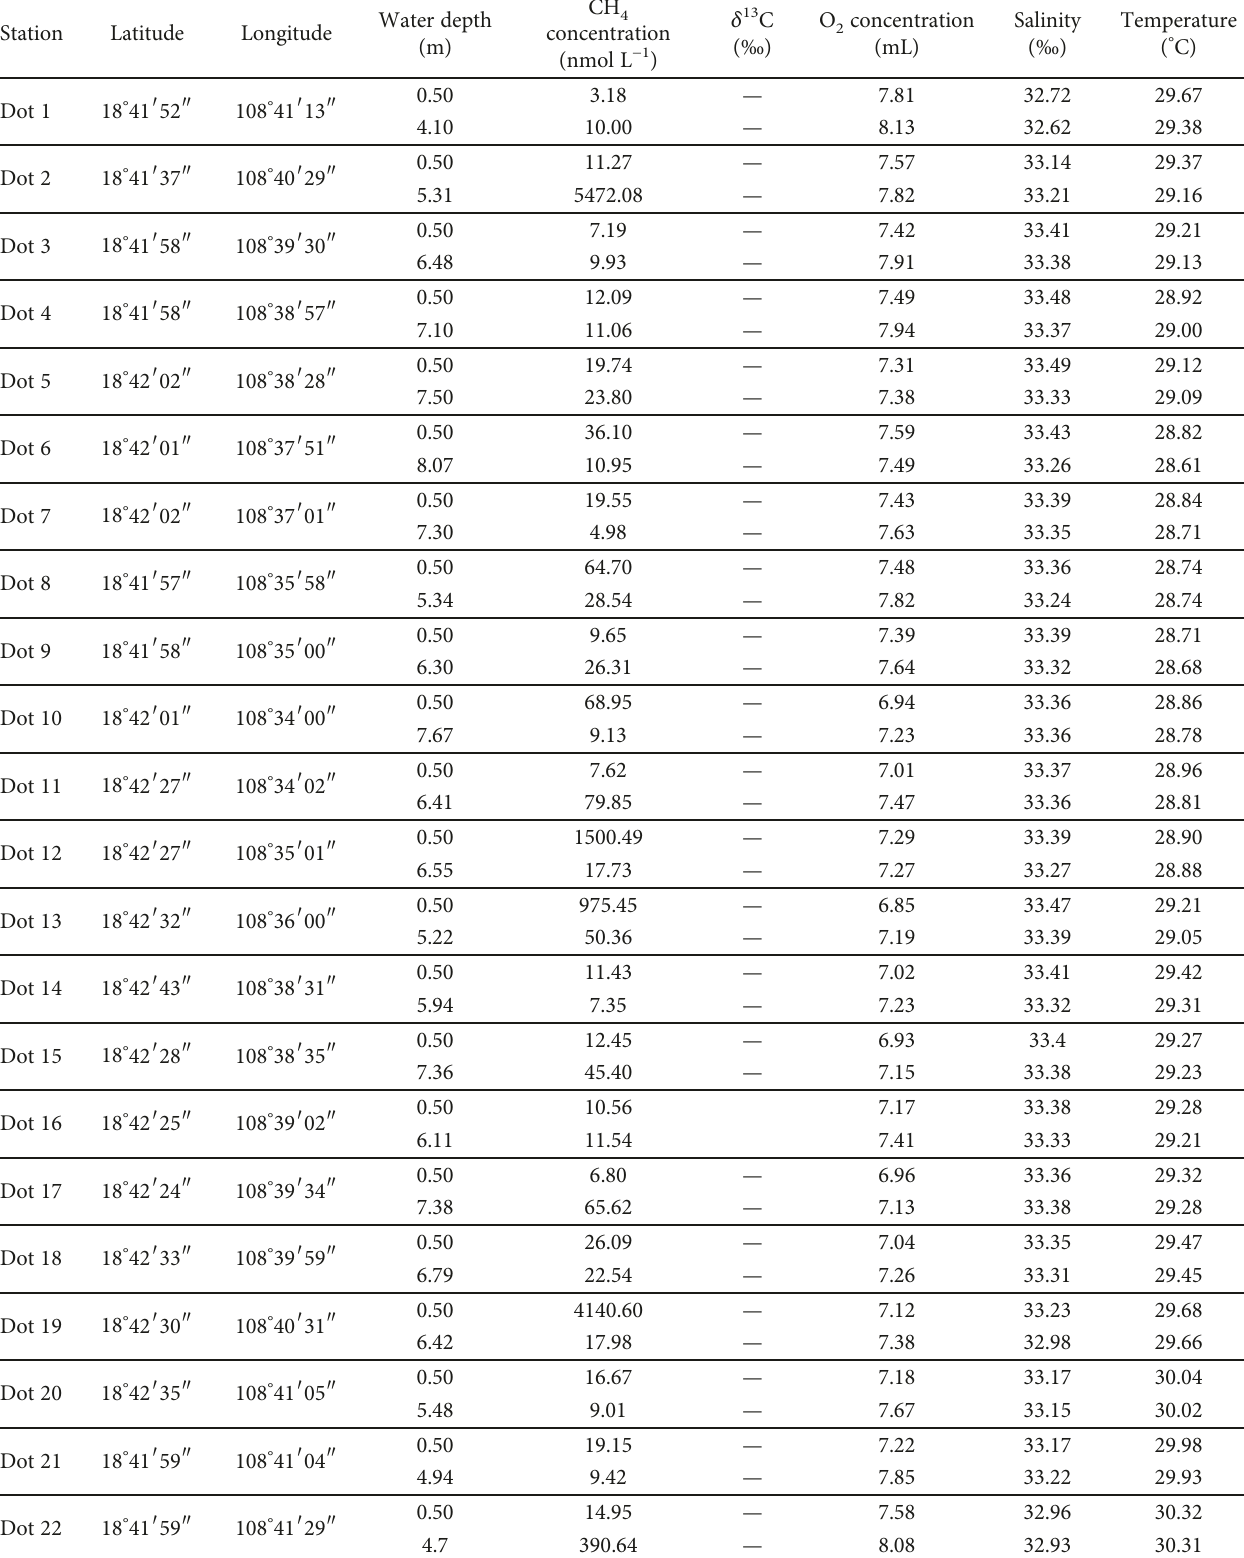
Table 1: The CH concentrations of bottom and surface seawater, as well as the O 4 sites, and the δ 13 C CH values in seawater and bubbles from the Lingtou Promontory seep area. 4 Station